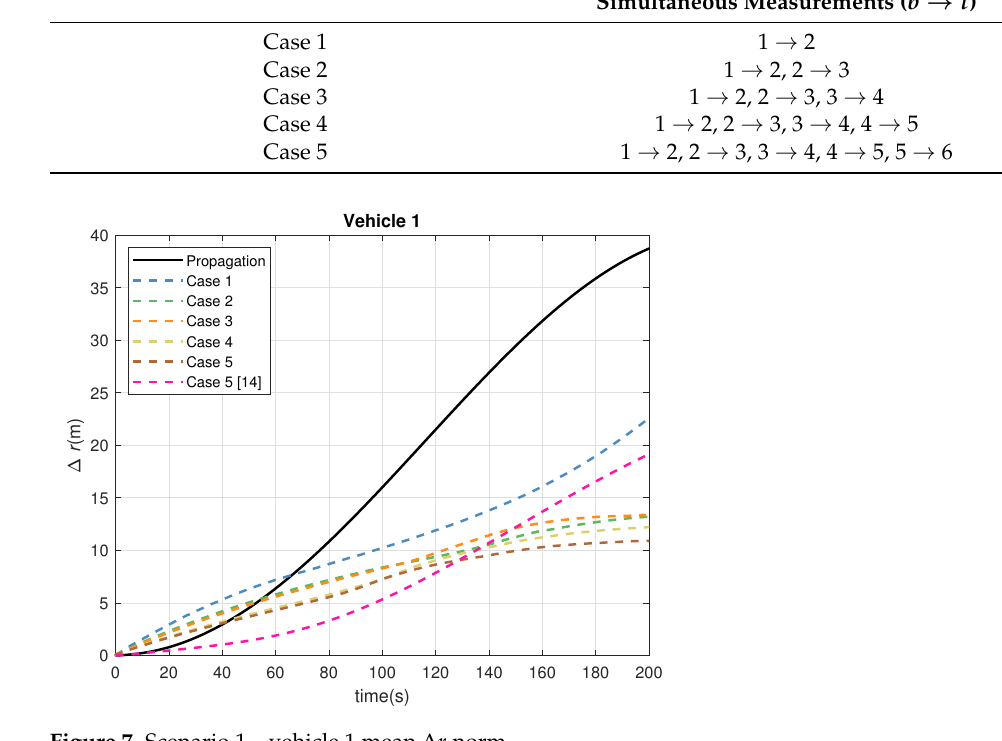
Figure 7. Scenario 1—vehicle 1 mean ∆ r norm.